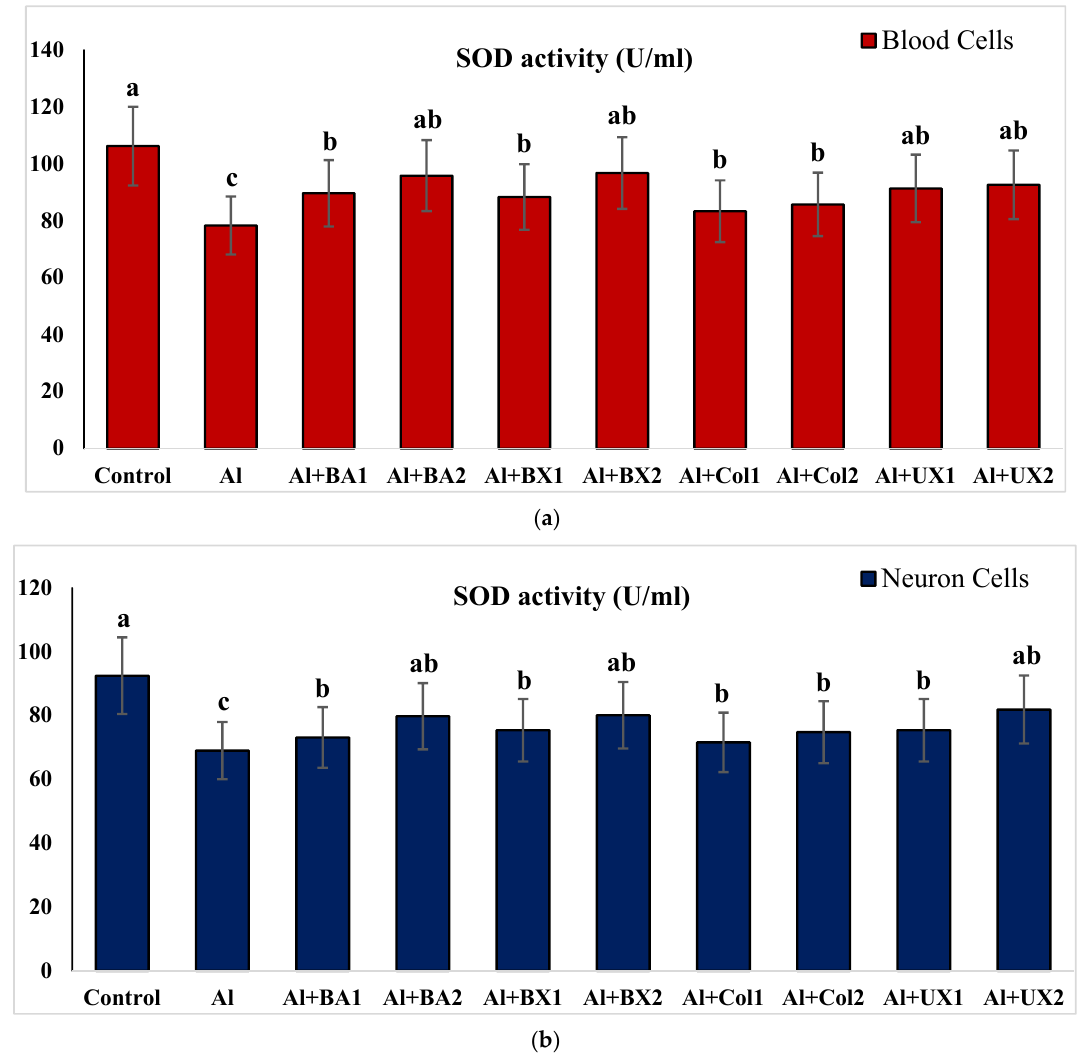
Figure 2. The effect of Al and boron treatments in ( a ) human blood and ( b ) PRCNs cells on SOD activity. (Control: untreated cultures; positive control as Al: 20 ppm AlCl 3 ; BA1: 5 ppm boric acid; BA2: 10 ppm boric acid; BX1: 5 ppm borax; BX2: 10 ppm borax; Col1: 5 ppm colemanite; Col2: 10 ppm colemanite; UX1: 5 ppm ulexite; UX2: 10 ppm ulexite; values in the same column with different